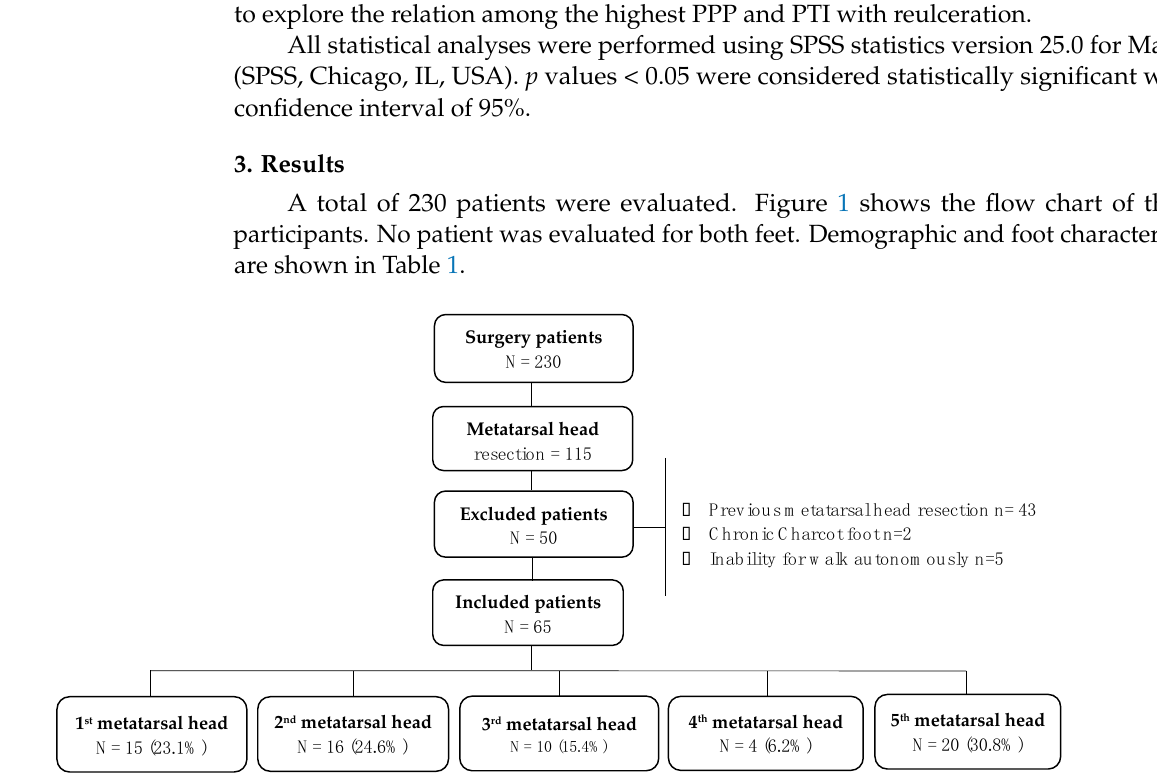
Figure 1. Study flow diagram. Legend: Flow chart of the 230 participants screened. After exclusion criteria 65 patients were included for analyses. Table 1. Baseline clinical data.